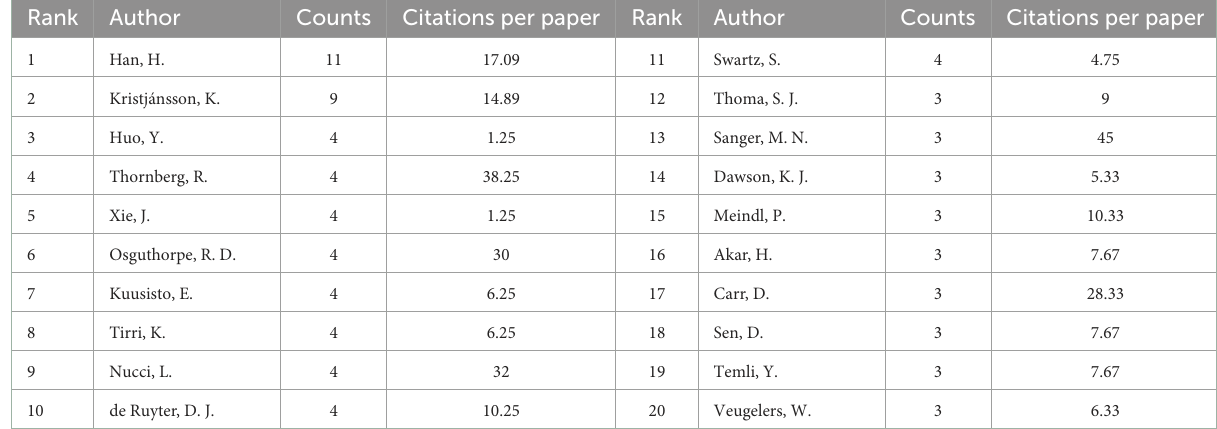
TABLE 2 Core authors in the moral education research